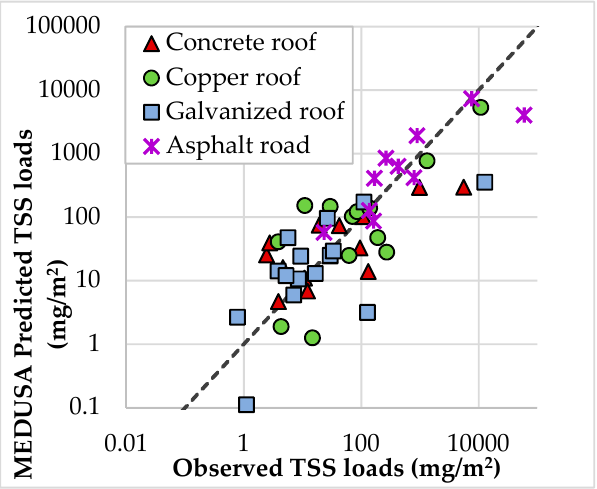
Figure 4. Predicted total suspended solids (TSS) loads against observed loads for Okeover surfaces.